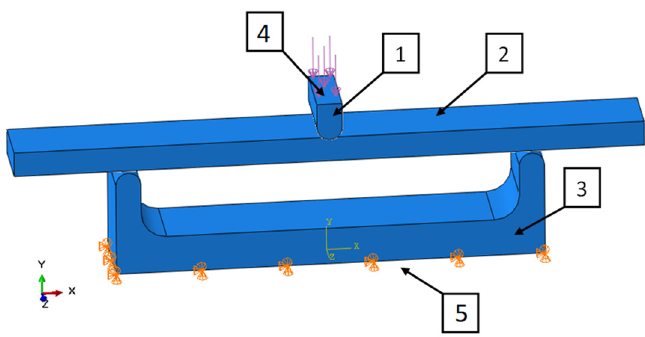
Figure 5. Simulation model of P series samples: (1) pressing element, (2) tested sample, (3) base, (4) place of application, (5) place of receiving force.